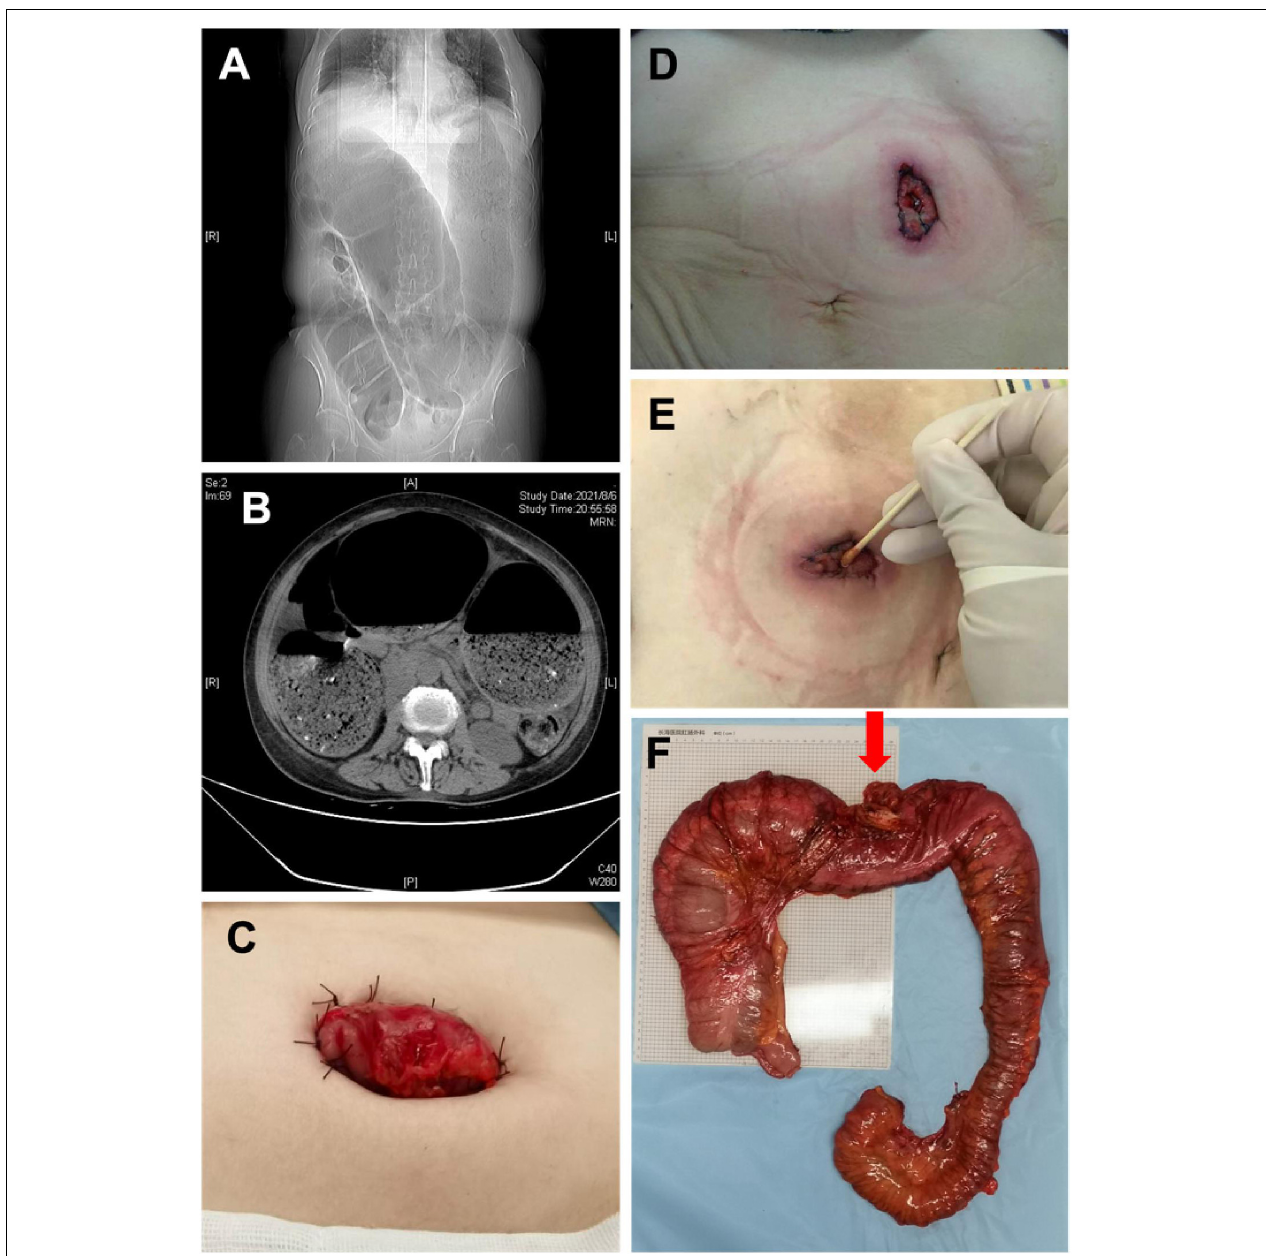
FIGURE 2 | (A) X-ray image manifestations of adult idiopathic megacolon; (B) CT image of adult idiopathic megacolon; (C) photos after colostomy; (D) 1 week after colostomy; (E) 1 month after colostomy; (F) the intestine specimen after subtotal resection (Red arrow: transverse colostomy).